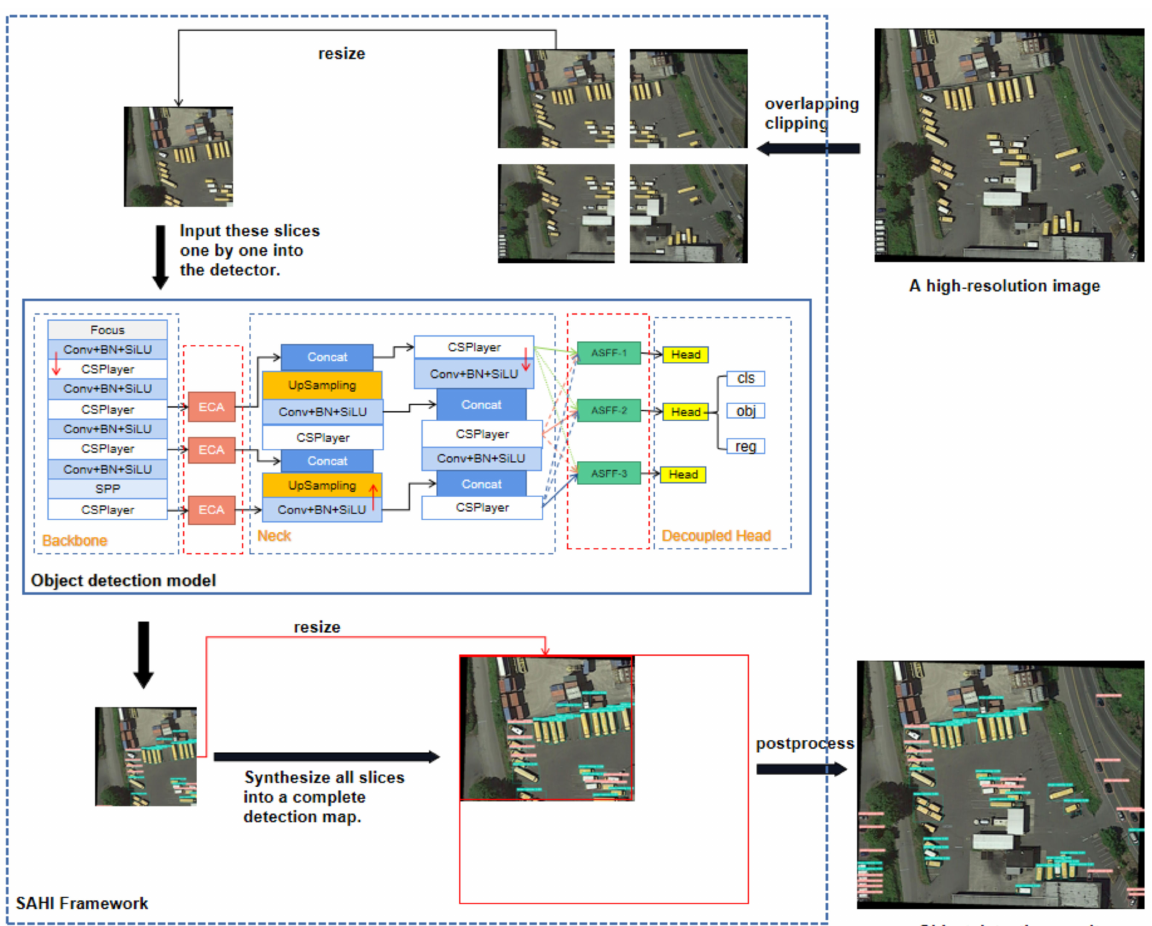
Figure 3. Detection process of RS-YOLOX.